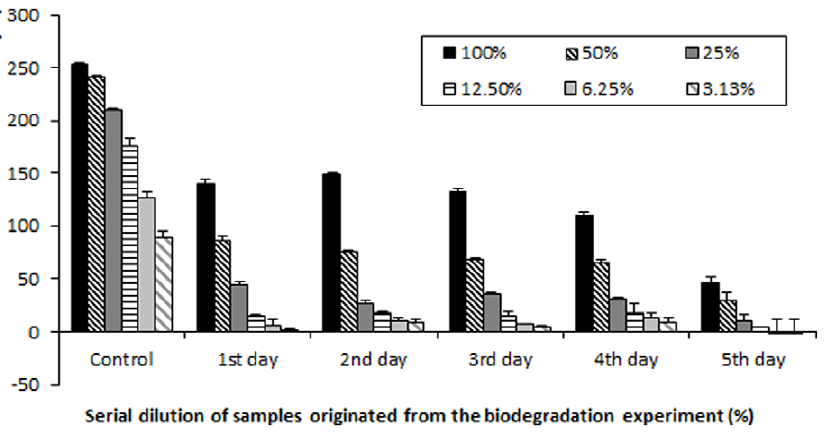
Figure 1. Remained estrogen effect in the zearalenone metabolism of Rhodococcuspyridinivorans analysed by the bioluminescens yeast reporter system (BLYES). The results show that the incubation with Rhodococcus pyridinivorans K408 decreased the estrogenic activity of zearalenone. After 5 days, remained estrogen effect was 81.75% compared to control. The results of the BLYES based estrogenic biotest showed good correlation with ZEA concentration measurement via HPLC-FLD.